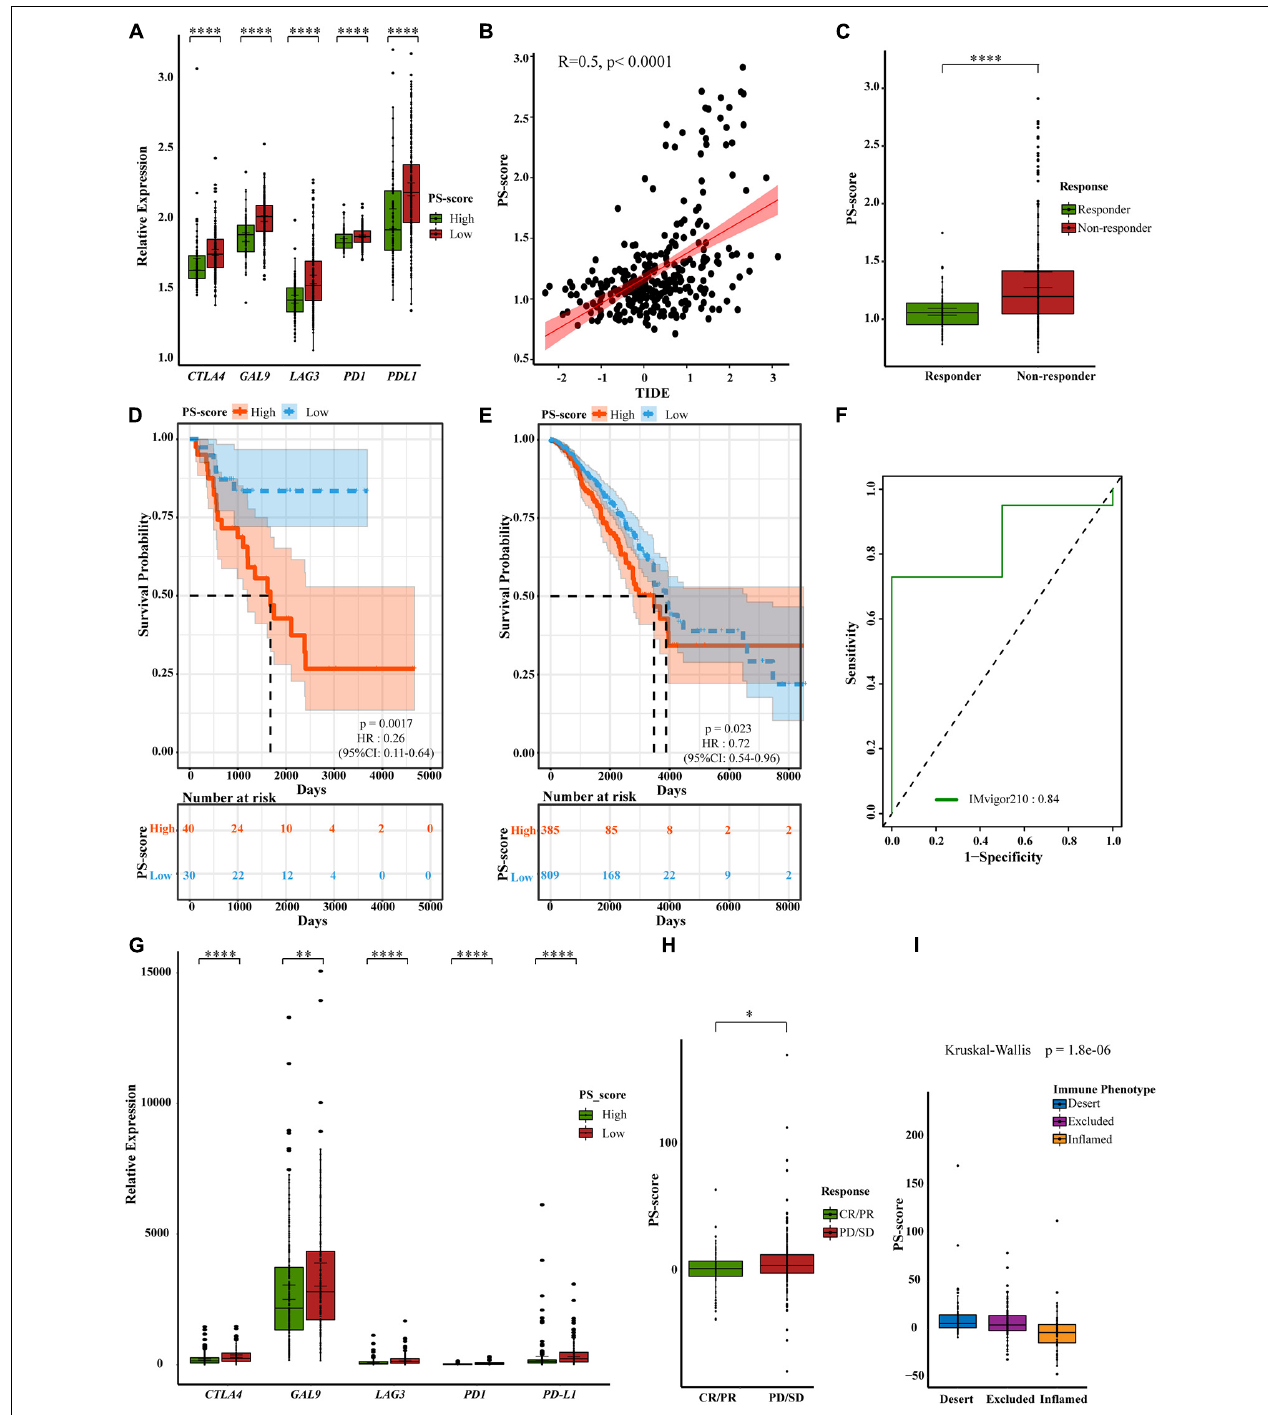
FIGURE 7 | A powerful role of the PS-score scoring model in PD1/PD-L1 immunotherapy. (A) Differential expression of immune checkpoint genes in low PS-score subgroup ( n = 209) and high PS-score subgroup ( n = 91) of GSE62254 cohort (Wilcox test, ∗∗∗∗ P < 0 · 0001). (B) The relationship between TIDE and PS-score in GSE62254 cohort (Spearman test, p < 0 · 0001). (C) Different PS-score in responder group ( n = 112) and non-responder group ( n = 188) in GSE62254 cohort (Wilcox test, ∗∗∗∗ P < 0.00001). (D,E) OS curves for the PS-score with the cut-off value 1,258 of samples in TCGA-ACC cohort (Log-rank test, p = 0.0017) and TCGA-BRCA cohort (Log-rank test, p = 0.023). (F) ROC curves about PS-score in IMvigor210. (G) Differential expression of immune checkpoint genes in low PS-score subgroup ( n = 126) and high PS-score subgroup ( n = 222) of IMvigor210 cohort (Wilcox test, ∗∗ P < 0.01; ∗∗∗∗ P < 0.0001). (H) . Different PS-score in CR/PR group ( n = 68) and SD/PD group ( n = 230) in IMvigor210 cohort (Wilcox test, ∗ P < 0.05). SD, stable disease; PD, progressive disease; CR, complete response; PR, partial response. (I) Different PS-score in IMvigor210 cohort’s immune phenotypes (Kruskal-Wallis test, P = 1.8e-06).